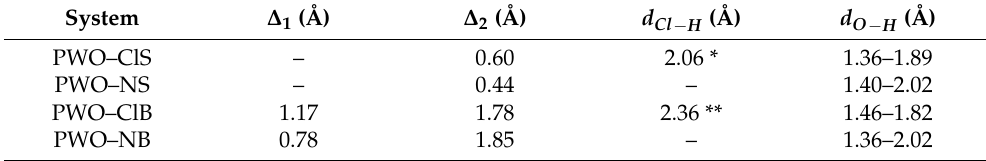
Figure 3. ( a ) Representation of the bond lengths and torsion angles between the rings of the optimized structure of ES–PANI phase interacting with the WO 3 ·2H 2 O structure. ( b ) Planes formed by the central W and O atoms, ( c ) O 1 and O 2 planes formed by two water layers in the WO 3 ·2H 2 O structure, and ( d ) Identification of the bond lengths of the WO 3 ·2H 2 O unit described in Table 2. Table 2. Hydrogen bond lengths and distances between the oxide layers and polymer phase.